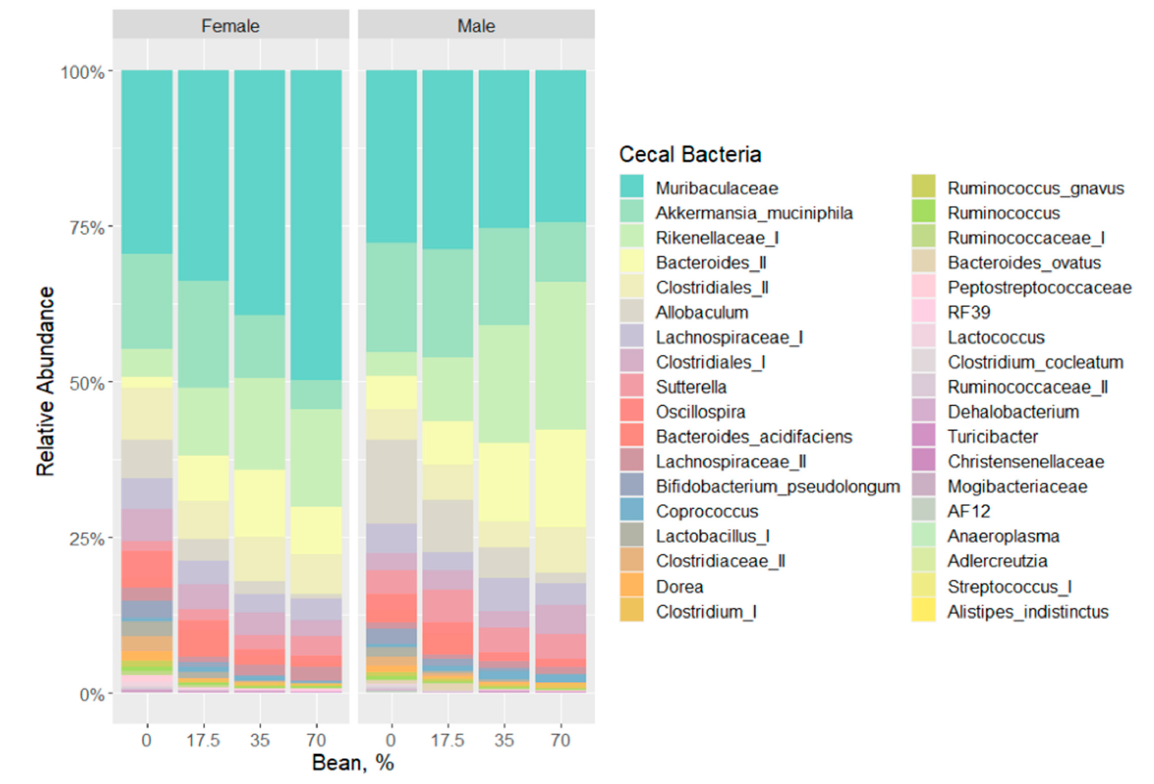
Figure 4. Relative abundance of cecal bacteria at their lowest level of identified taxonomy across the diet groups of each sex cohort.